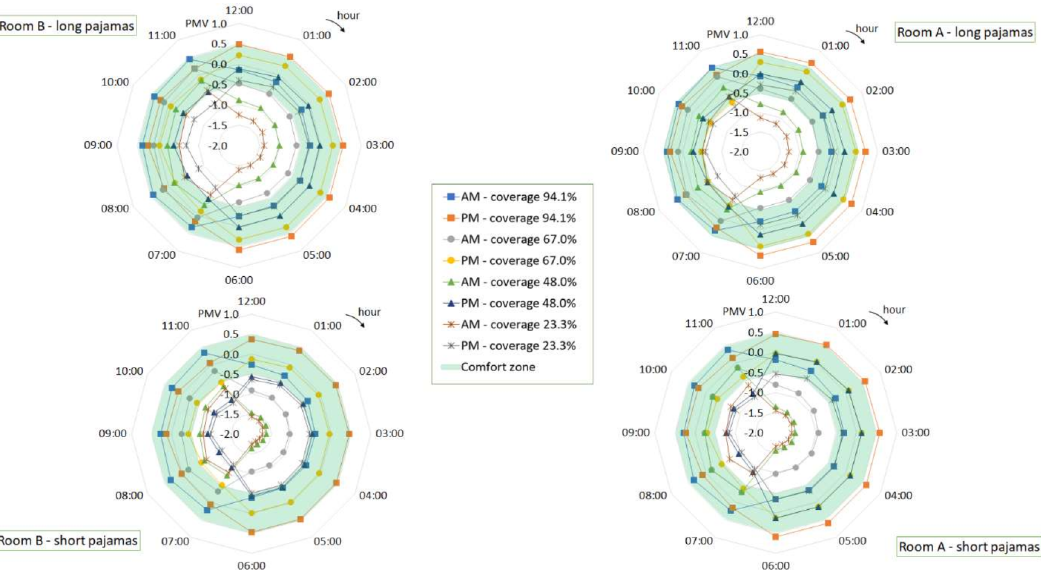
Figure 6. Hourly PMV of bedridden patients: different coverage rates and clothing on the spring